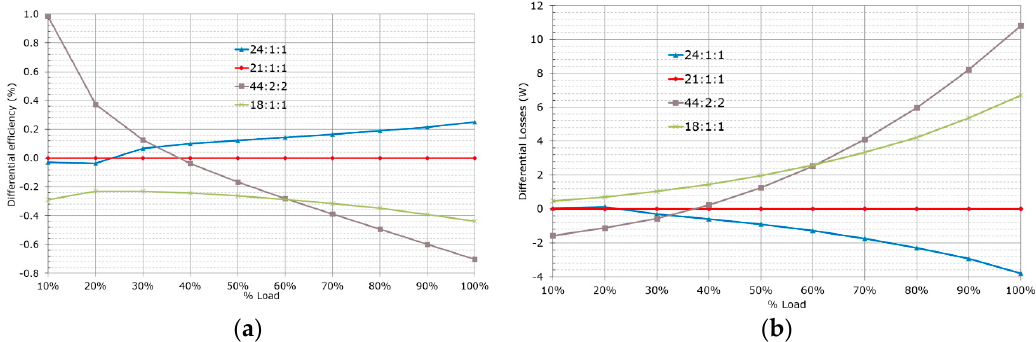
Figure 8. Performance comparison for different transformer turns ratios. The value of L r is adjusted to maintain the required input voltage range. The original reference converter had a turn ratio of 44:2:2. The optimized converter has a turn ratio of 21:1:1. ( a ) Differential efficiency of the converter with the different configurations; ( b ) differential power loss of the converter with the different configurations.